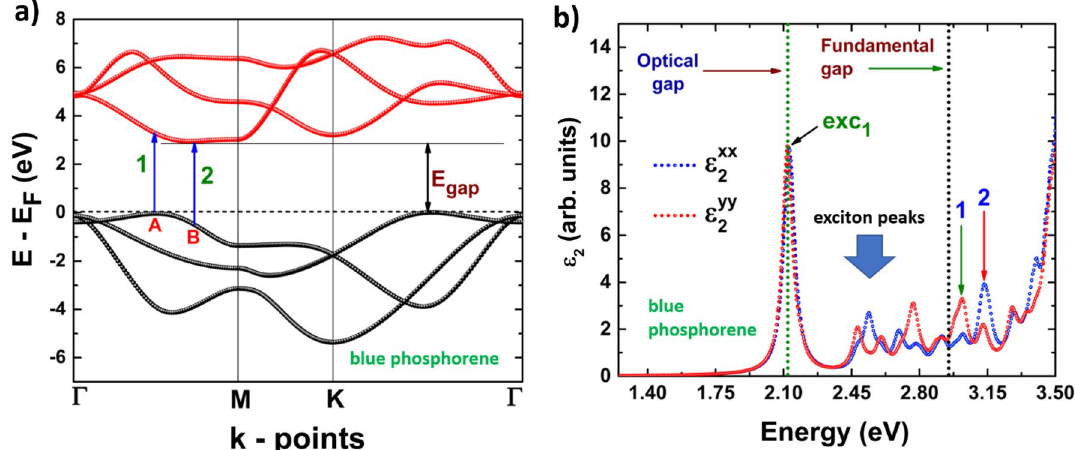
Figure 8. ( a ) Electronic band structure of blue phosphorene including the information of two important direct transitions. ( b ) Dielectric function imaginary part of blue phosphorene showing the values of the corresponding optical and fundamental gaps as well as exciton peaks. The peaks associated with direct transitions depicted in ( a ) are also included.